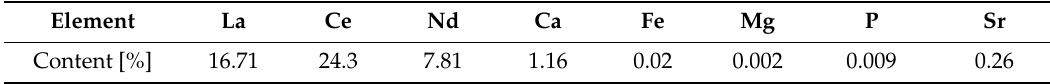
Table 8. Composition of the mixed-RE